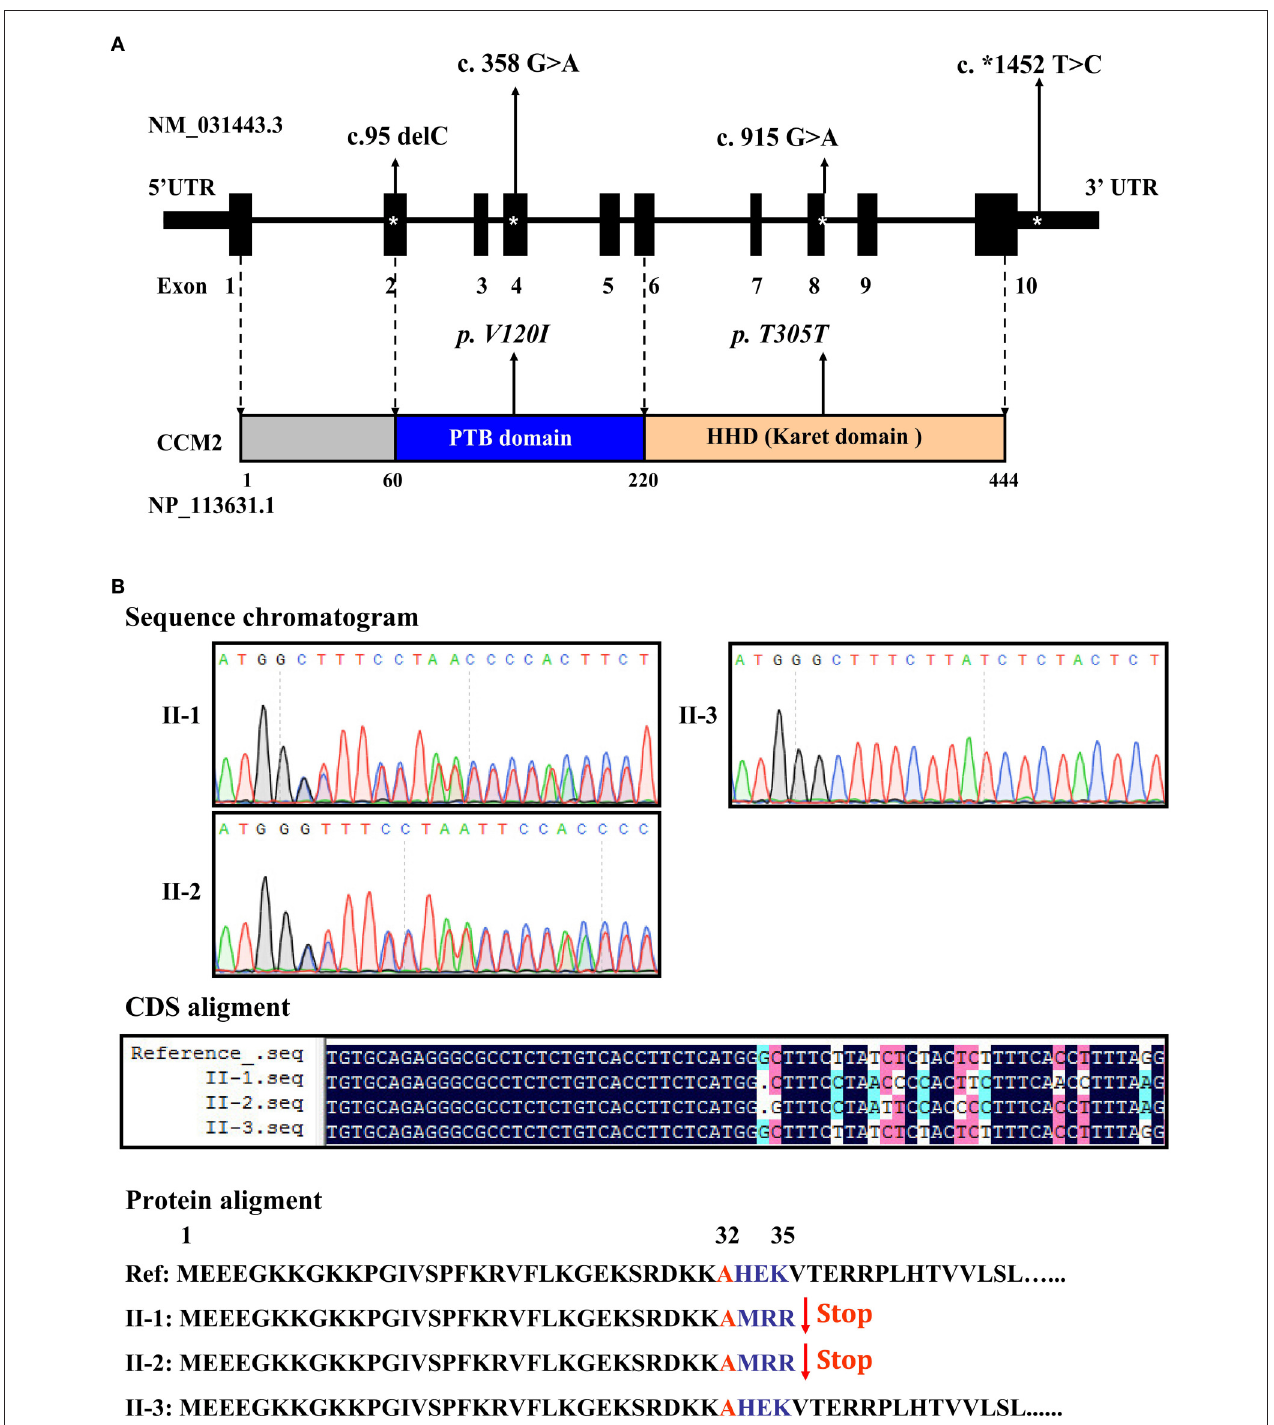
FIGURE 3 | Distribution and function of mutations in the CCM2 gene. (A) Schematic representation of four CCM2 gene mutations identified in the domains of CCM2 -coding protein in the studied Chinese family with FCCM. (B) A novel frameshift mutation in exon 2 of the CCM2 gene. This deletion (c.95 delC), located in exon 2, was heterozygous in both siblings with CCMs. It resulted in a stop codon in the 36th original codon and produced a 35-amino acid, truncated form of CCM2, without the PTB domain and all of the C-terminal domains.